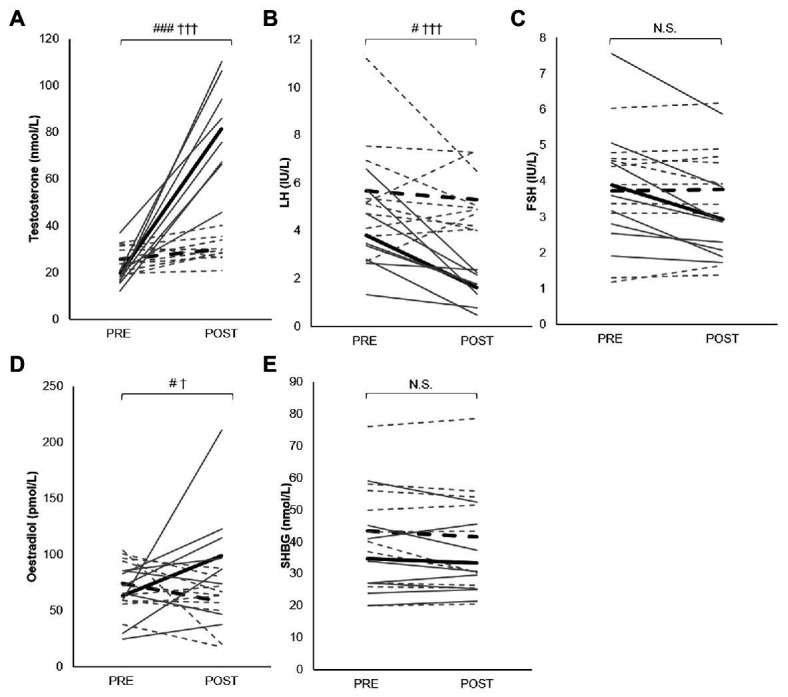
Changes in levels of serum testosterone (A), luteinizing hormone (LH; B), follicle stimulating hormone (FSH; C), oestradiol (D), and sex hormone binding globulin (SHBG; E) from pre to post TE administration (solid lines; n = 8) and PLA administration (dashed lines; n = 10). Gray lines indicate individual changes while black lines indicate group mean changes. Statistically significant differences are: #p < 0.05 compared with pre-injection, ###p < 0.001 compared with pre-injection, †p < 0.05 compared with PLA, †††p < 0.001 compared with PLA.